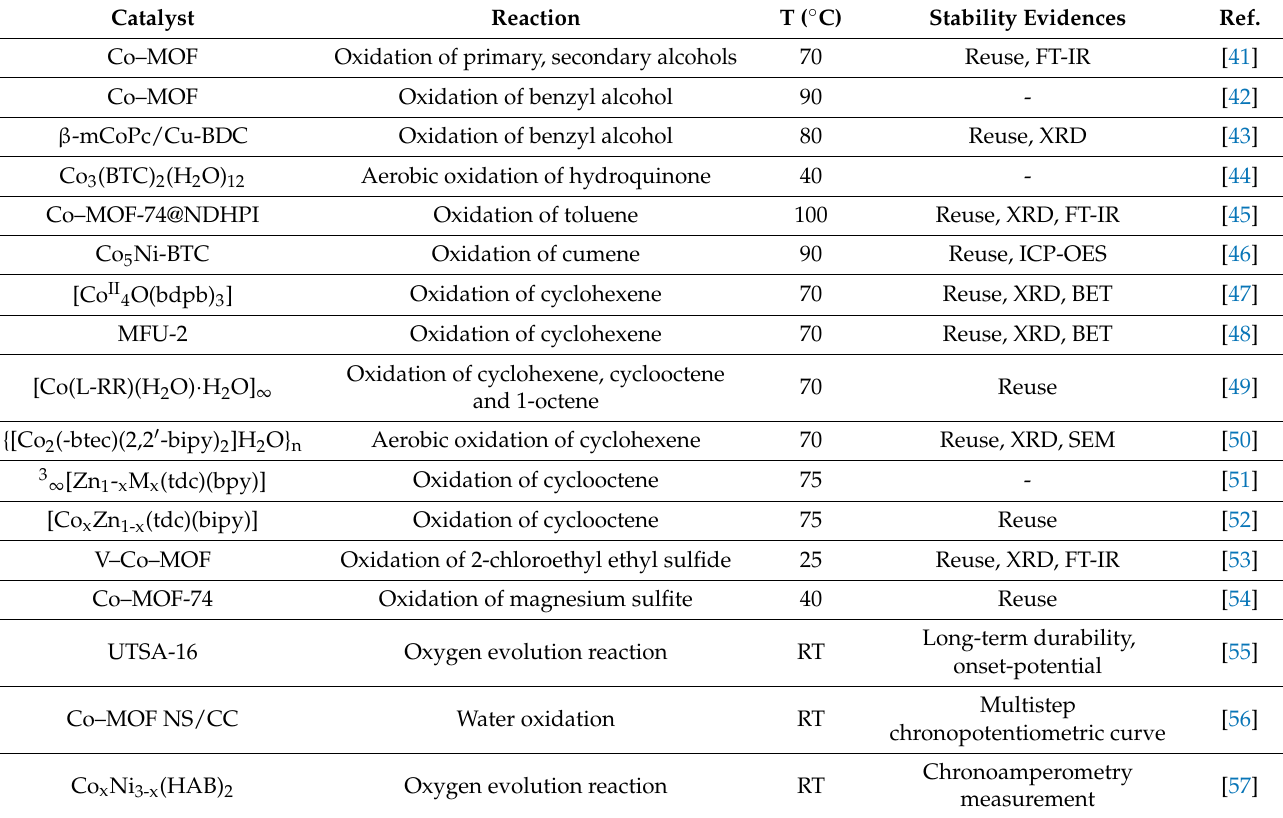
Table 1. List of Co–MOFs that have been reported for oxidation